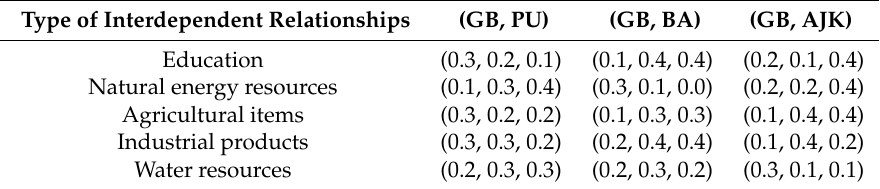
Table 6. IN set of interdependent relationships of Gilgit-Baltistan with other provinces. Type of Interdependent